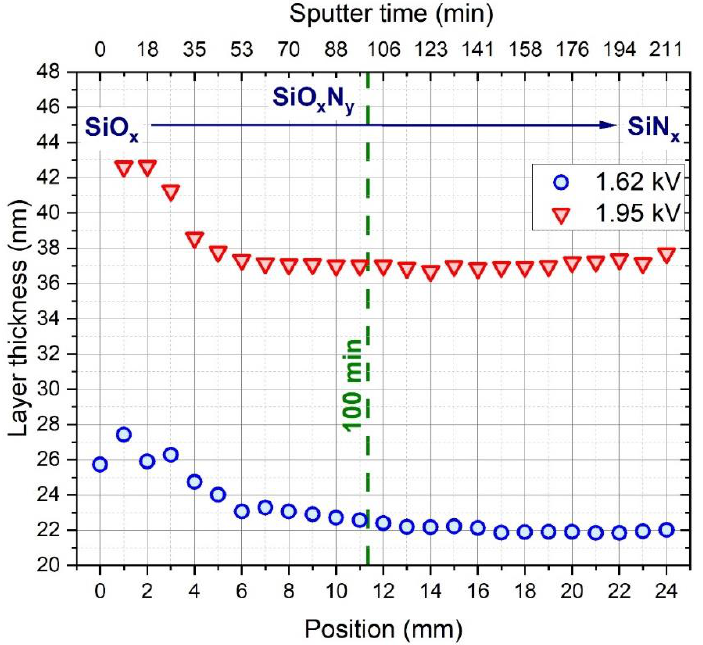
Figure 5. Thickness of the composition spread layers determined by